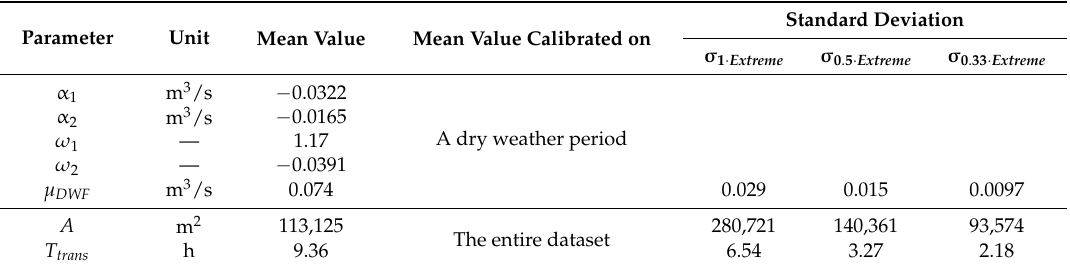
Table 1. Estimates of the constant DWF shape parameters as well as the mean and standard deviation of the three variable model parameters.